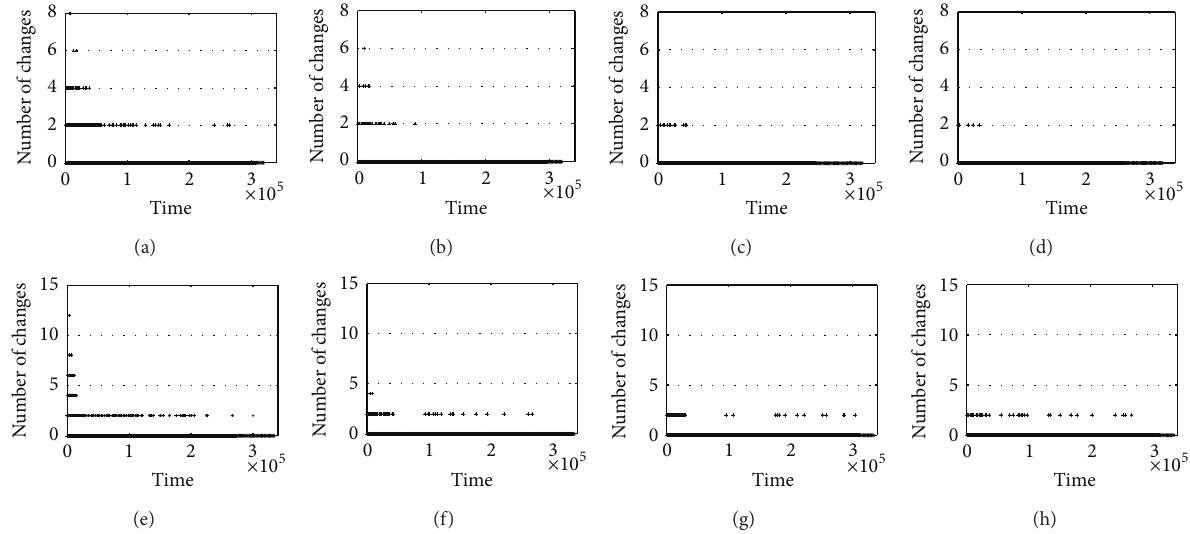
Figure 7: Number of changes in 0-1 matrix between two consecutive timestamps. Above: number of changes in SIGCOMM09 under 𝛿 = 0.2, 0.4, 0.6, and 0.8 (from (a) to (d)). Below: number of changes in INFOCOM06 under 𝛿 = 0.2, 0.4, 0.6, and 0.8 (from (e) to